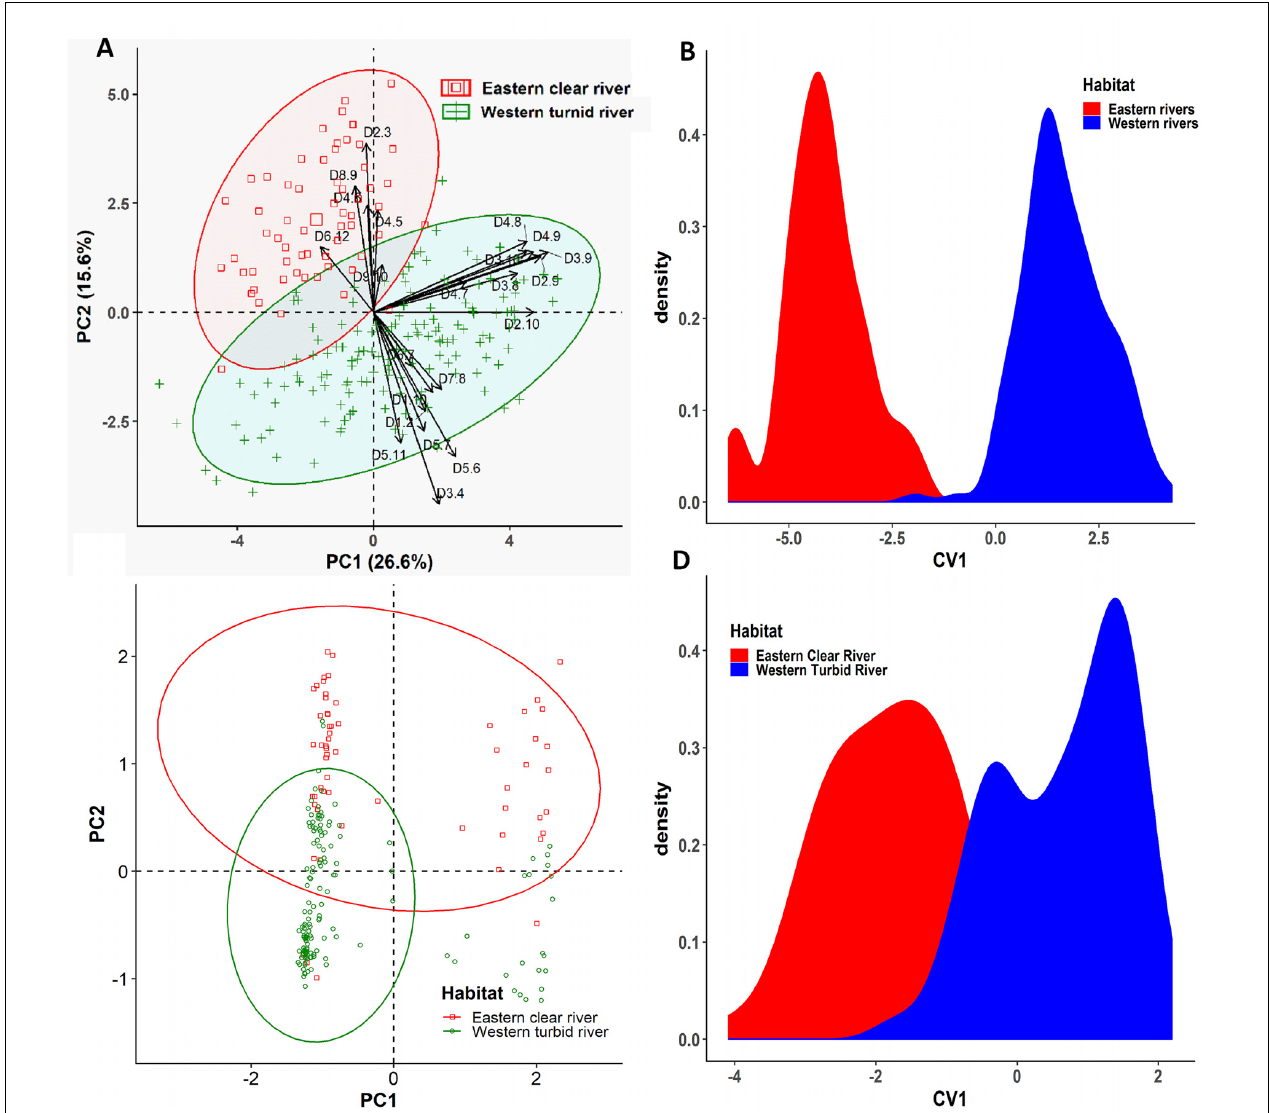
FIGURE 8 | The Principal Component Analysis (PCA) and Canonical Variate Analysis (CVA) showing the morpho-genetic variation of Hilsa shad Tenualosa ilisha collected from the eastern clear water (total suspended sediment 20–750 mg/l) and the western turbid water (total suspended sediment 190–1600 mg/l). (A) Biplots of the PCA using 22 truss morphometric distances of Hilsa shad; (B) biplots of sample centroids of the canonical variate scores are shown based on the 22 truss morphometric distances; (C) biplots of the PCA using 74 putatively adaptive panels of SNP loci identified by the F ST OutFLANK approach; (D) biplots of sample centroids of the canonical variate scores are shown based on 74 putatively adaptive panels of SNP loci identified by the F ST OutFLANK